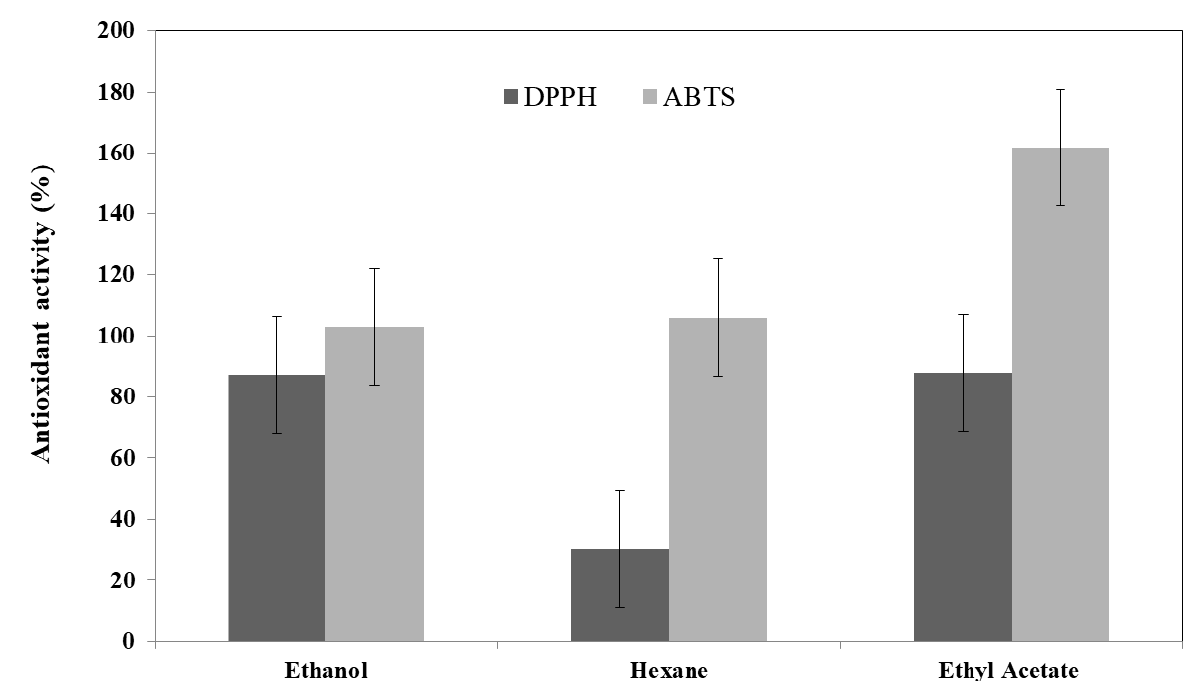
Figure 4. Antioxidant activity of the different extracts of Echinops spinosissimus .